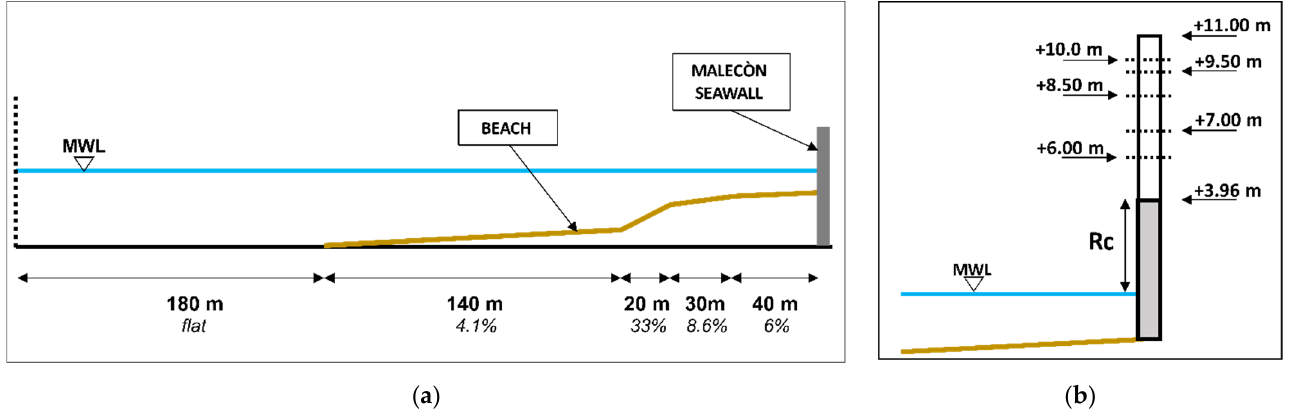
Figure 1. Characteristics investigated of the Havana foreshore and Malecón seawall. Panel ( a ) sketch of bathymetry; panel ( b ) different crests freeboard of vertical wall.